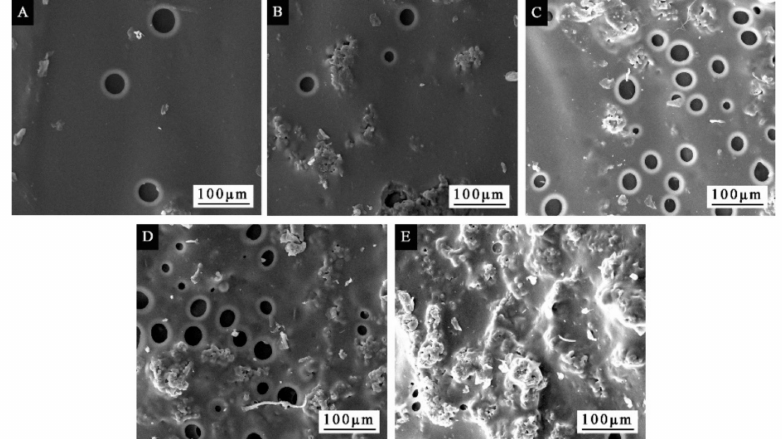
Figure 11. SEM of damaged waterborne coatings with di ff erent concentration of microcapsule